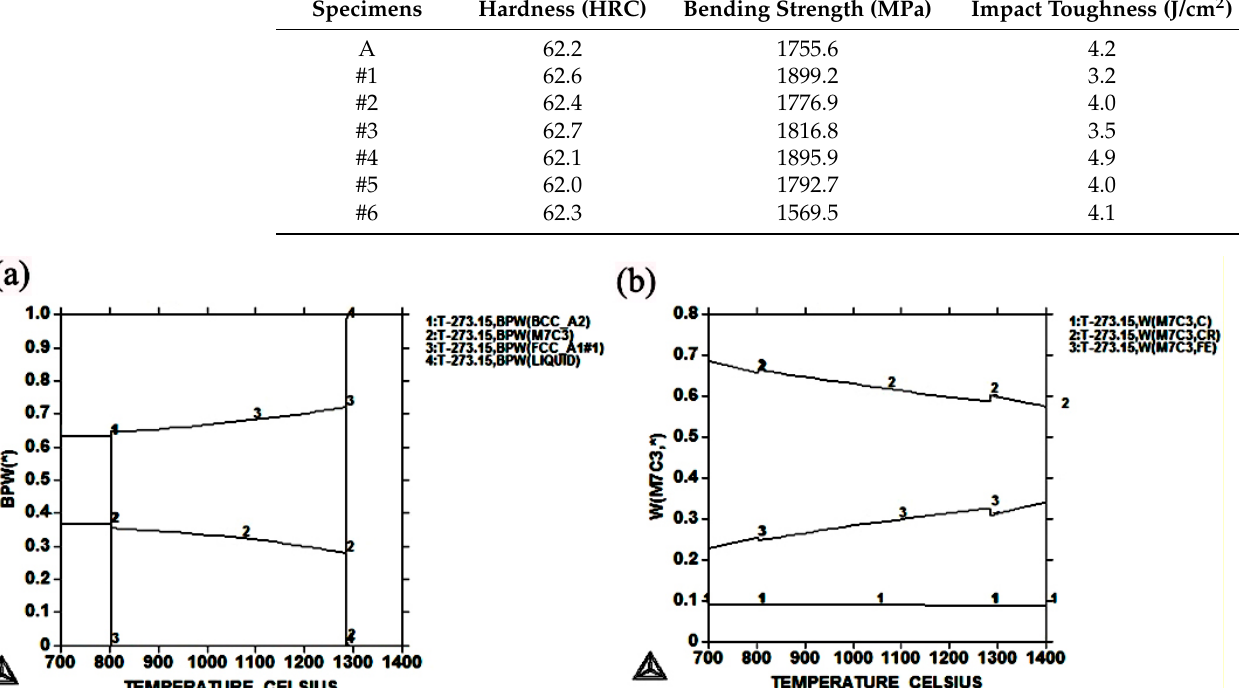
Figure 7. X-ray diffraction curves of a HCCI (powder, specimen A, and specimen #4). To further probe the difference of fracture failure mechanism between the sintered HCCIs manufactured by the two different SLPS methods, the morphologies of their fracture planes are examined by SEM and EDS as exhibited in Figures 8 and 9, and Table 6. The fractograph of specimen A in Figure 8a,b demonstrates a multitude of straight cleavage facets triggered by localized deflection of cleavage cracks along the duplex boundary, in which, mainly, are the primary carbides-martensite matrix interfaces. However, in specimen #4 (in Figure 8c,d), there are not only intergranular fractures across the M 7 C 3 network structure but also a few transcrytalline ones in the carbides, which is confirmed by EDS, as shown in Figure 9 and Table 6. It is worthy to point out that a few micro-sized dimples resulted from the cracks propagating along the interfaces between a fine carbide and a martensite matrix appearing in Figure 8d. Plenty of straight cleavage facets could be found in Figure 8b. Meanwhile, there appear many lacerated ridges at cleavage facets in Figure 8d, which illustrates that more energy would be required for